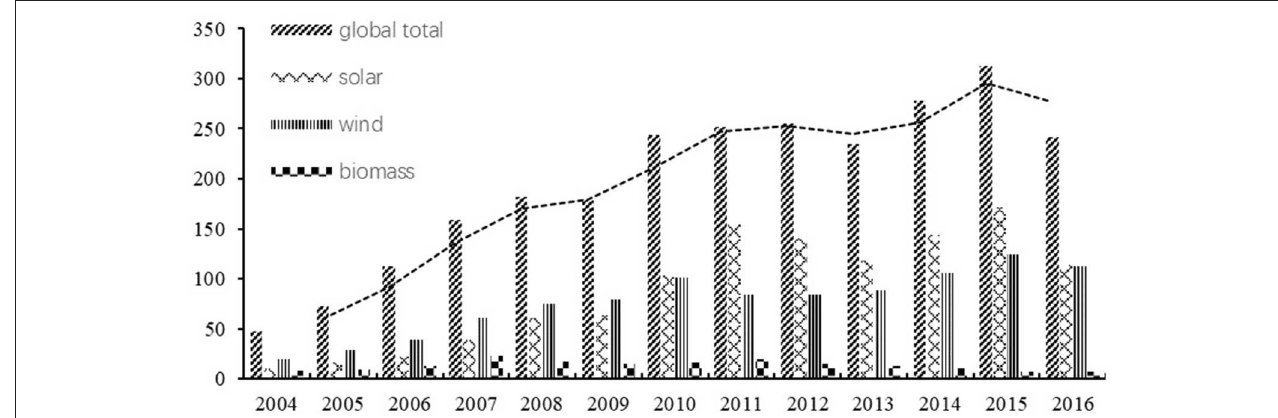
FIGURE 1 | Global statistics new energy investment by sector, 2004-2016, $BN (Source: UN Environment, Bloomberg New Energy